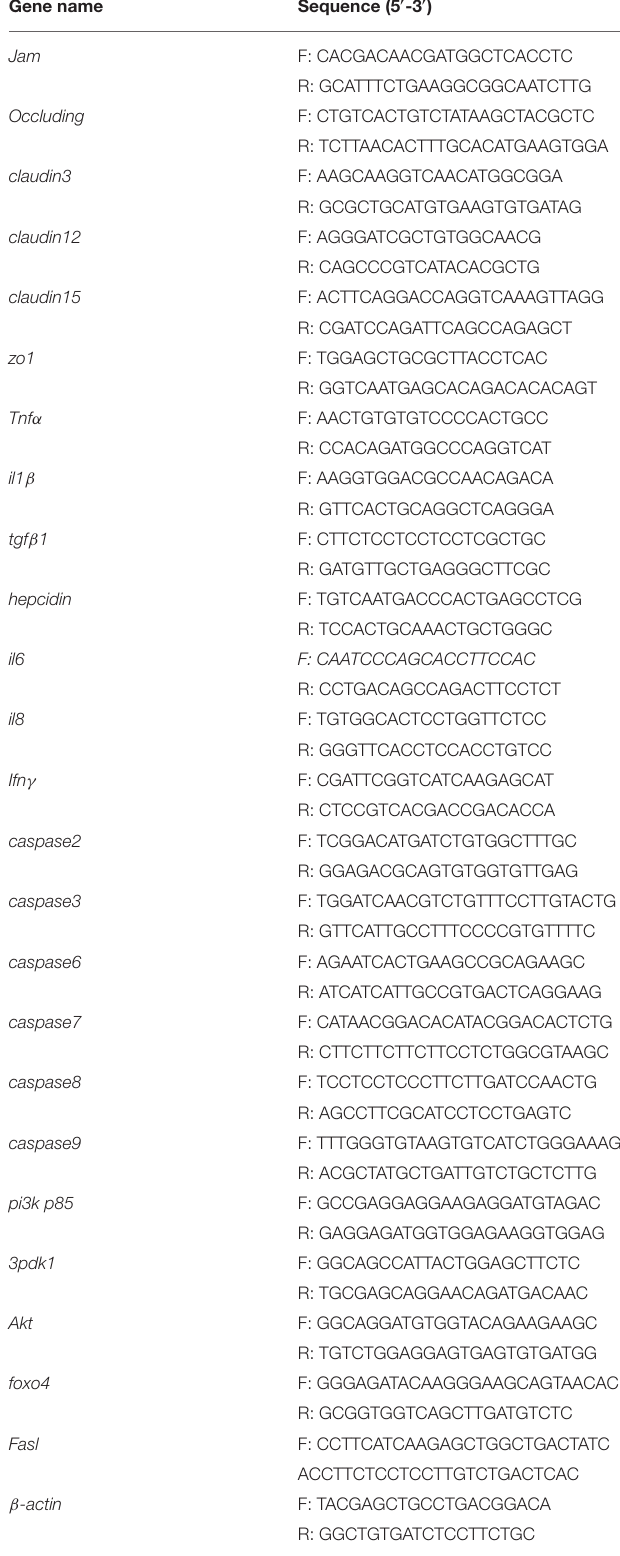
TABLE 2 | Primers used in this experiment for quantitative